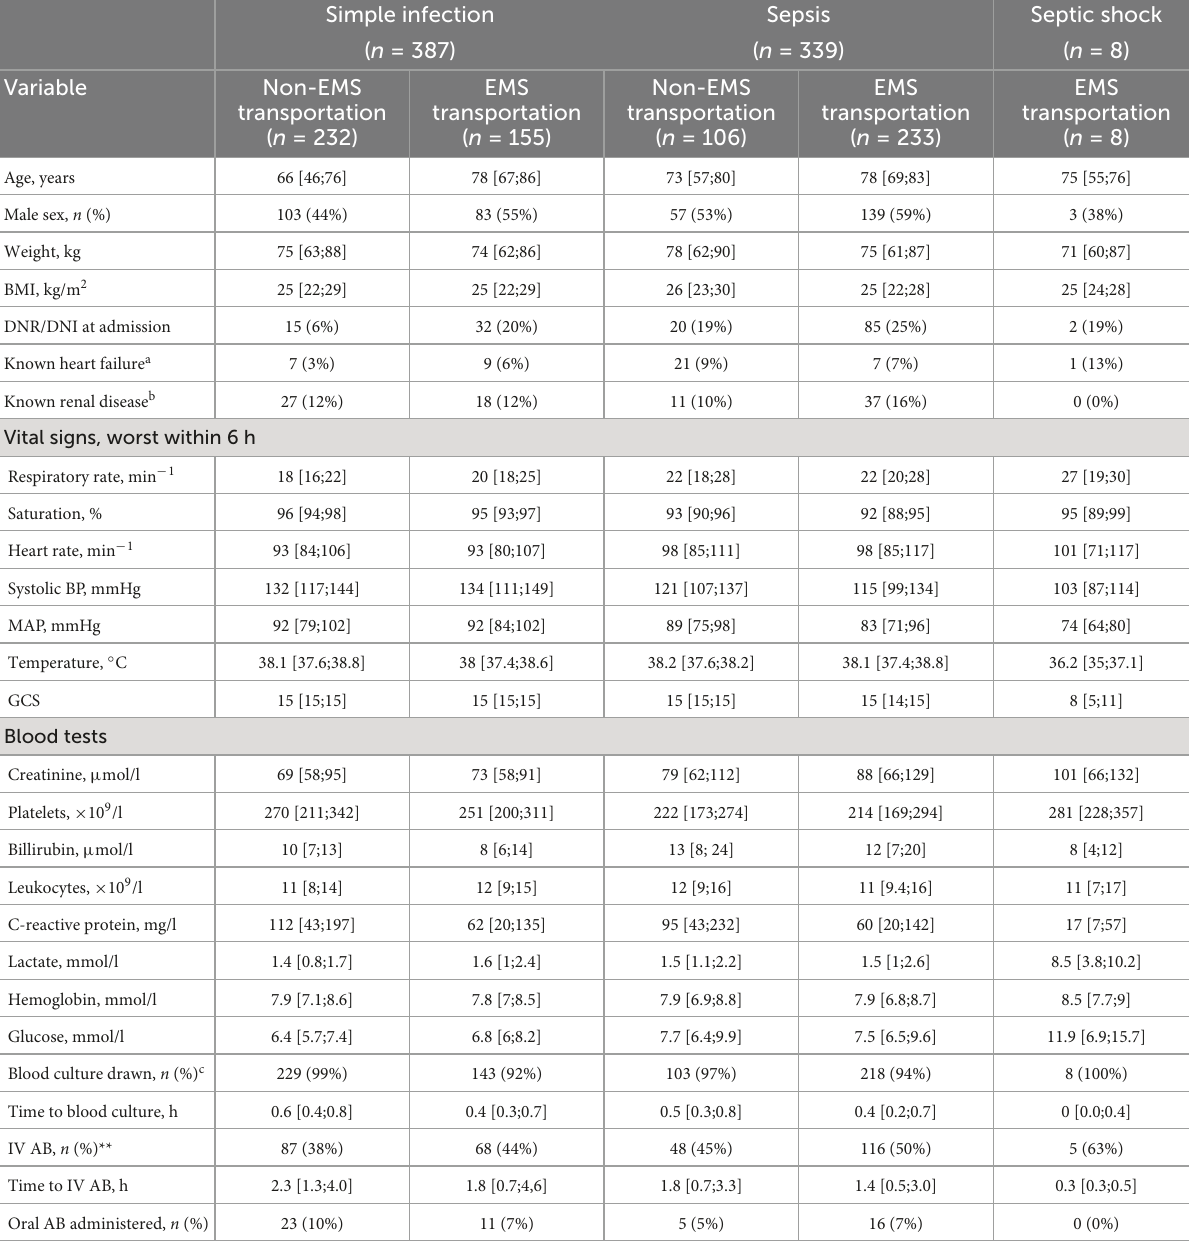
TABLE 1 Baseline characteristics of patients admitted minimum 24 h with fluids registered. Simple